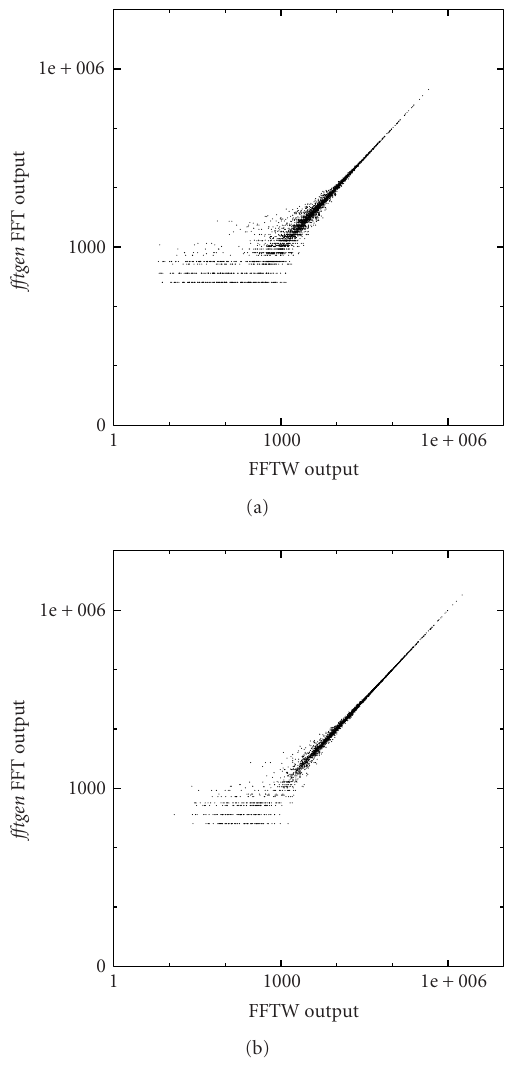
Figure 6: Scatter plot of ff tgen FFT output against FFTW output for the TIMIT signal x (a) and 4 x (b), scales are